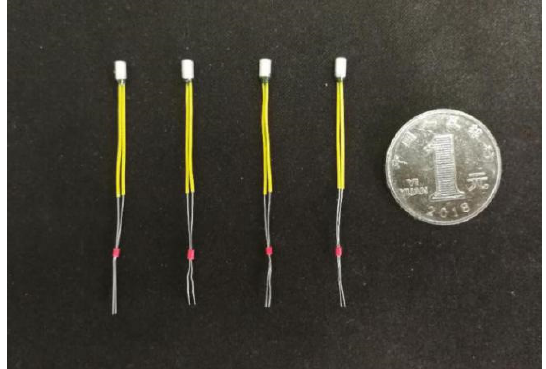
Figure 29. Microdetonators.